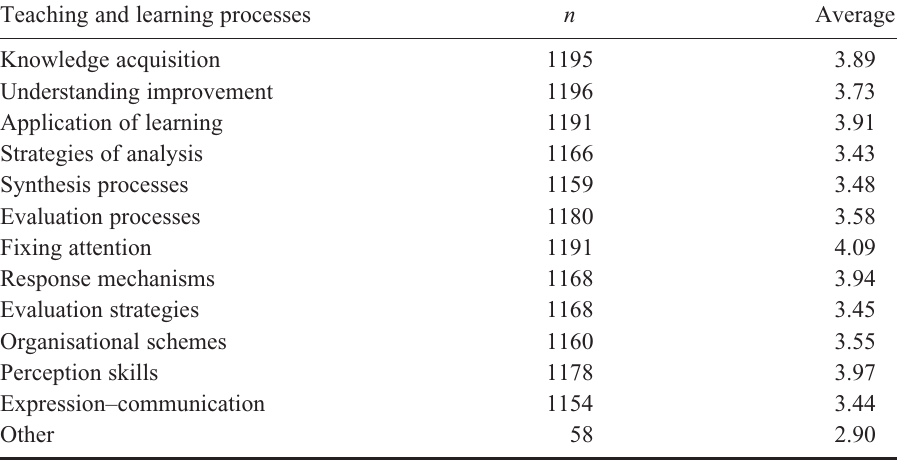
Table 5. Influence of ICT in developing teaching and learning